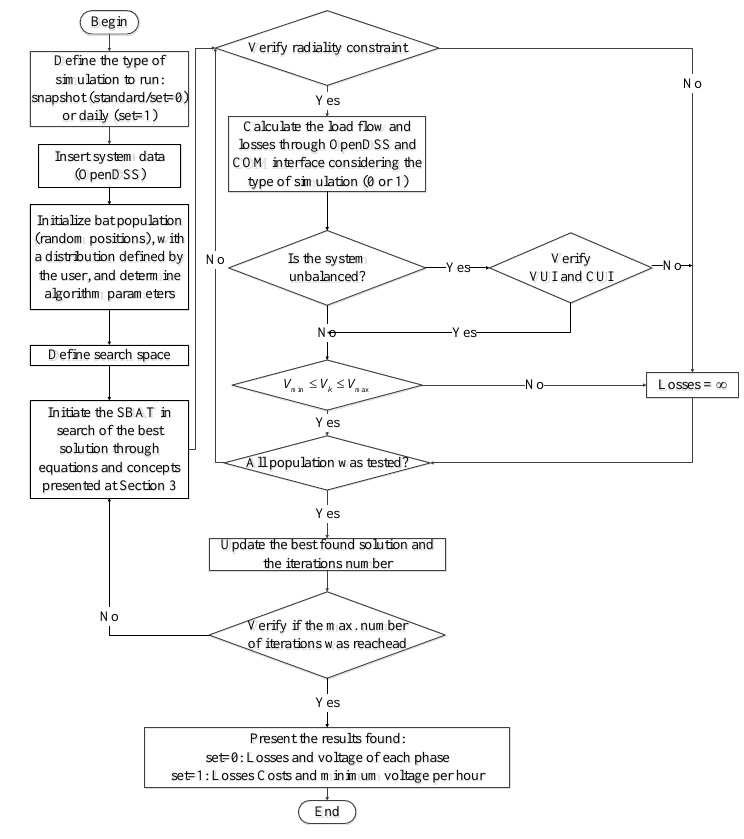
Figure 1. SBAT to solve the DNR problem